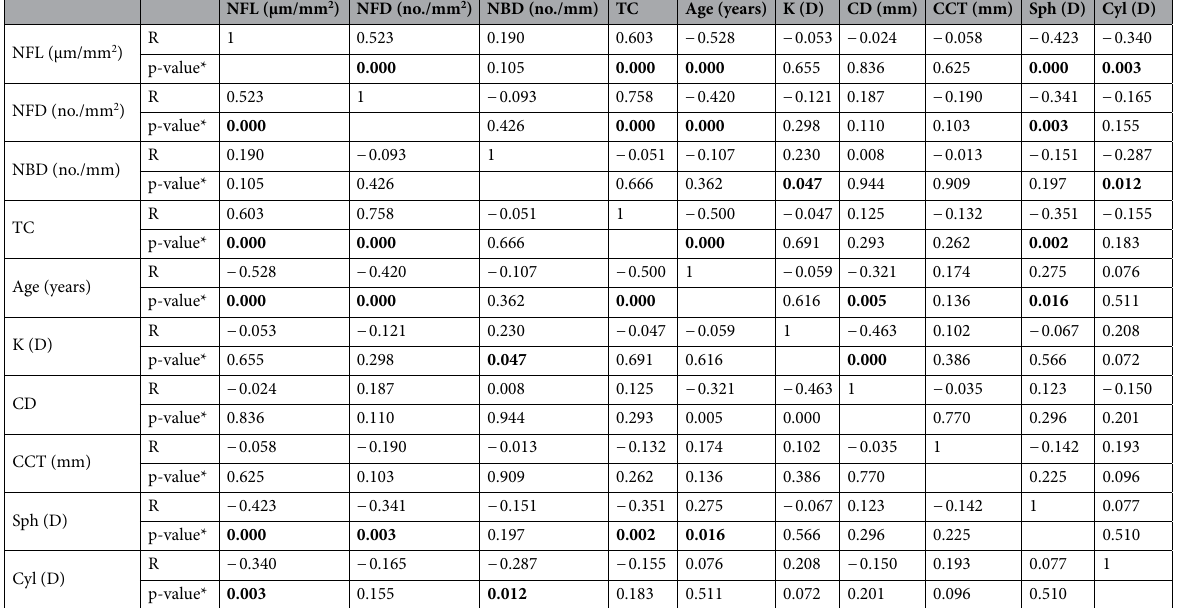
Table 4. Pearson correlation matrix. * NFL nerve fiber length (µm/mm 2 ), NFD nerve fiber density (no./mm 2 ), NBD nerve beadings density (no./mm), TC tortuosity coefficient, K corneal curvature ( D diopters), CD corneal diameter (mm), CCT corneal thickness (µm), Sph sphere ( D diopters), Cyl cylinder ( D diopters). **Bold values denote statistical significance at the p value <